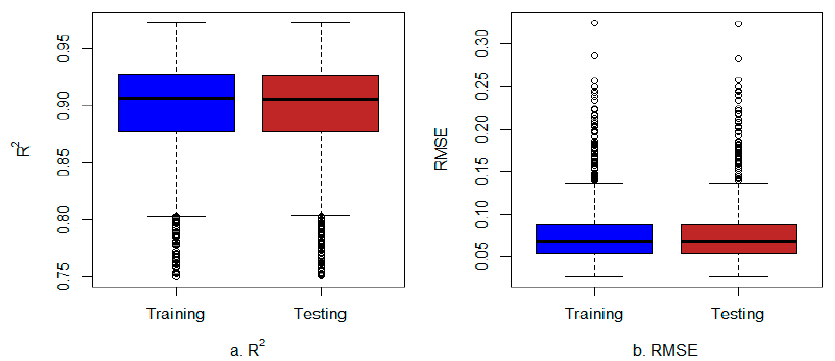
Figure 5. Boxplots of training and testing R 2 ( a ) and RMSE ( b ) for the imputation of Multi-Angle Implementation of Atmospheric Correction AOD.